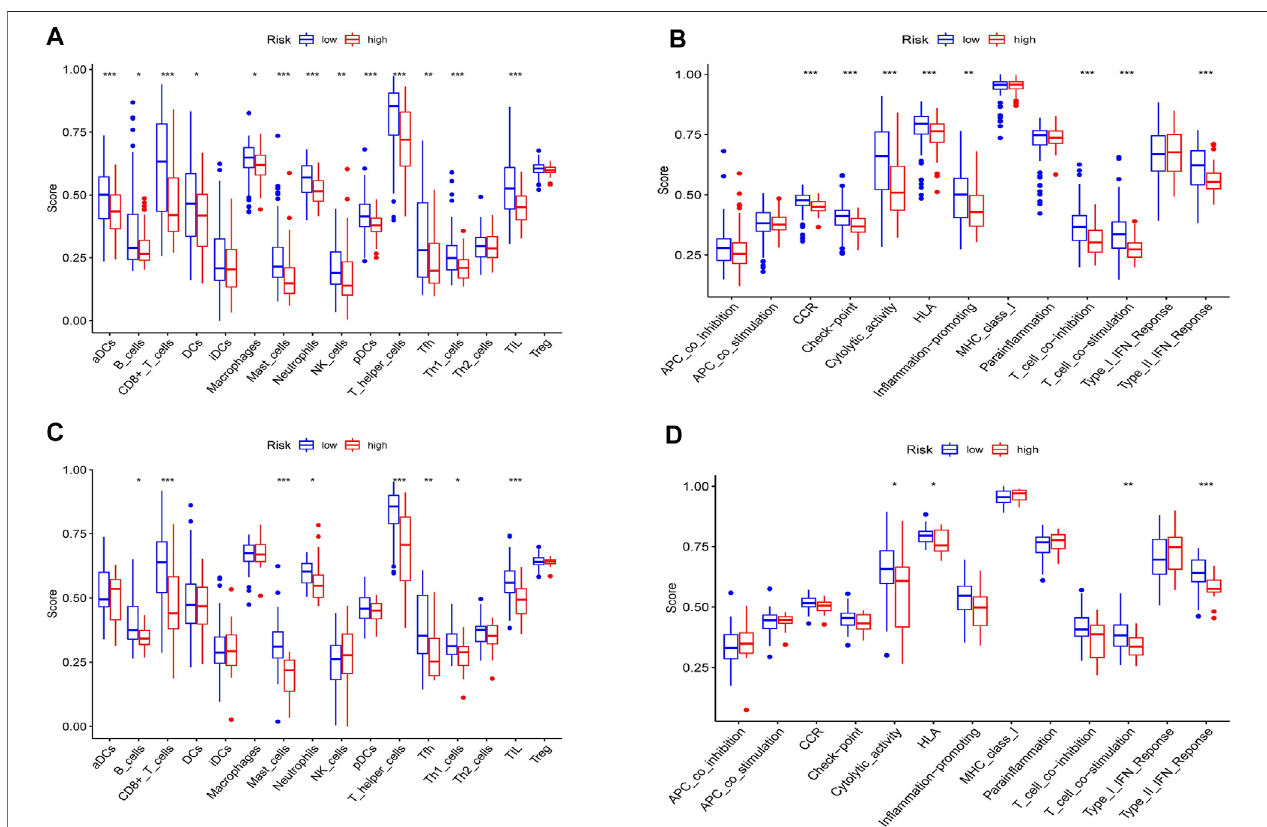
FIGURE 9 | Immune status analysis between high and low-risk groups in the TCGA and GEO cohorts. (A) Comparisons of the score of 16 immune cells between differentriskgroupsintheTCGAcohort. (B) Comparisonsofthescoreof13immunefunctionsbetweendifferentriskgroupsintheTCGAcohort. (C) Comparisonsofthe scoreof16immunecellsbetweendifferentriskgroupsintheGEOcohort. (D) Comparisonsofthescoreof13immunefunctionsbetweendifferentriskgroupsintheGEO cohort. * p < 0.05, ** p < 0.01, *** p <